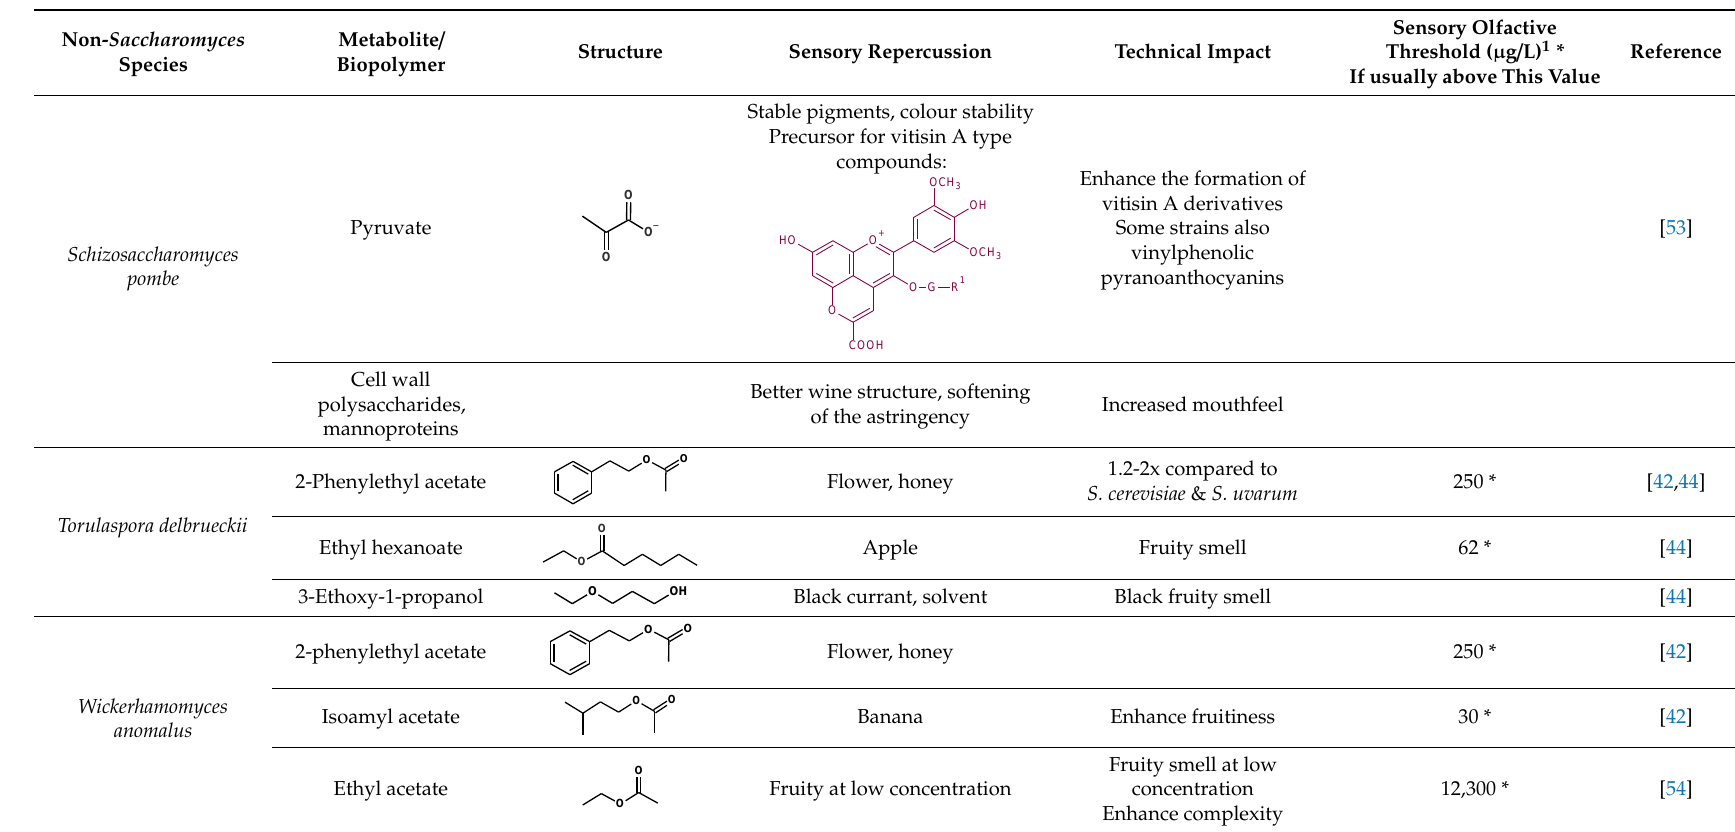
Stable pigments, colour stability Precursor for vitisin A type compounds: